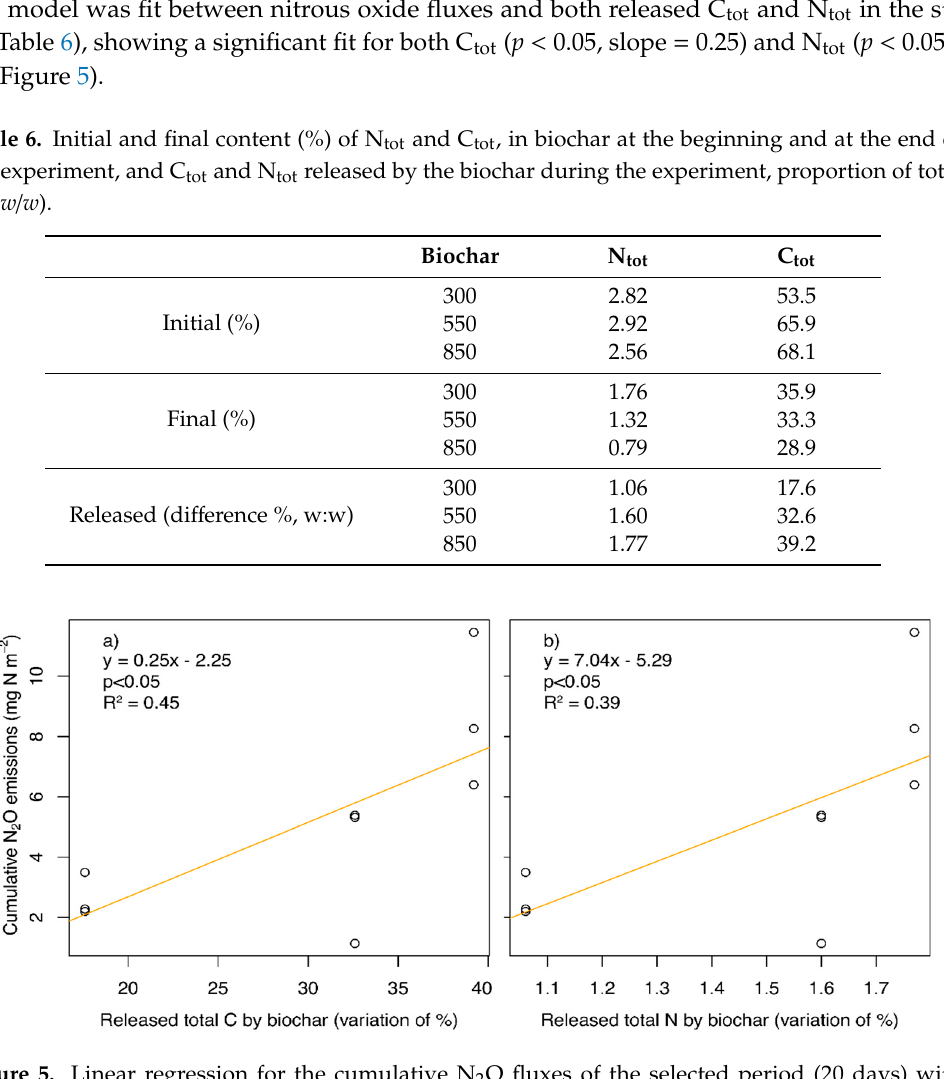
Figure 5. Linear regression for the cumulative N 2 O fluxes of the selected period (20 days) with ( a ) released total C, and ( b ) released total N. Table 6. Initial and final content (%) of N tot and C tot , in biochar at the beginning and at the end of the experiment, and C tot and N tot released by the biochar during the experiment, proportion of total (%, w / w ).